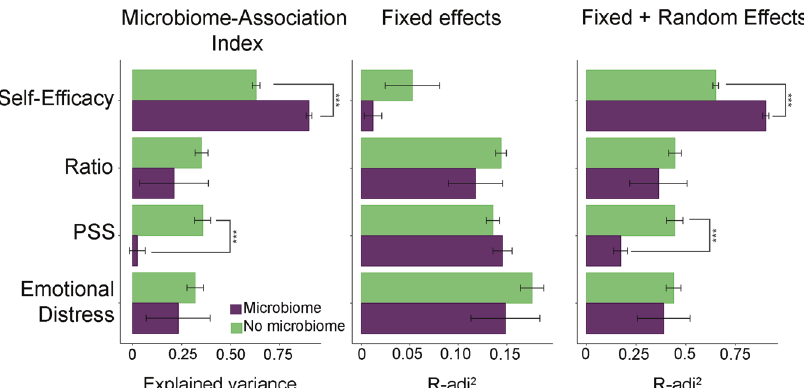
Fig. 4 Microbiota structure predictability of self-reported PS levels using Linear Mixed models. a Variability of rPS, rED and rSE explained by the gut microbiota composition; b By socio-demographic values; c Maximum explained variability by the Linear Mixed Models. Fixed factors were race/ethnicity for ED, PS and Ratio and nulliparity for SE. *** q <